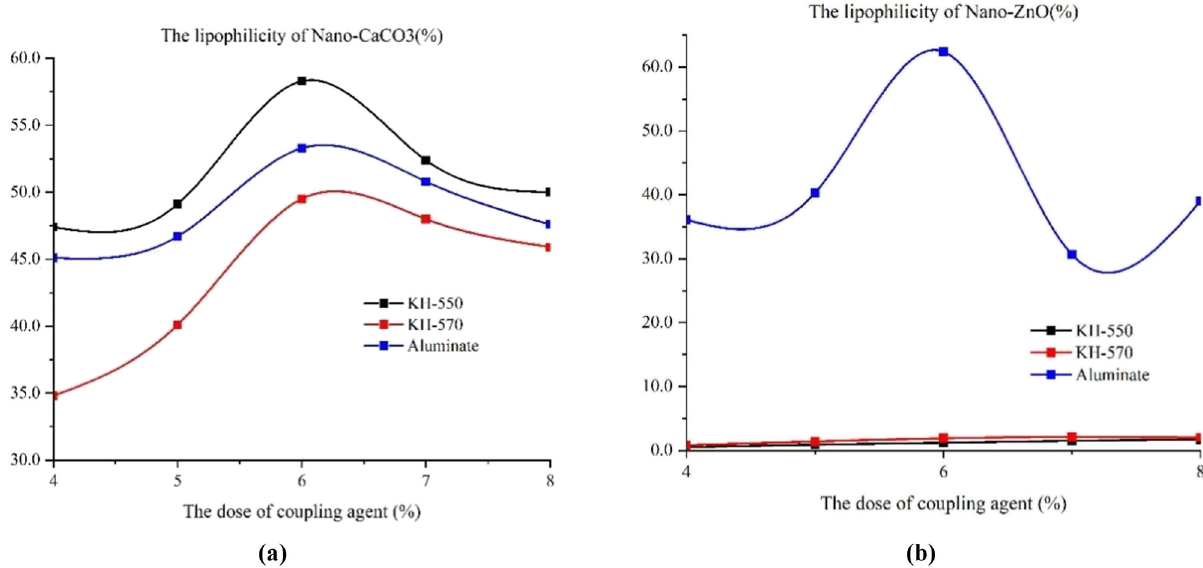
Figure 1: Lipophilic degree of activated nanomaterials: ( a ) lipophilic degree of activated nano - CaCO 3 and ( b ) lipophilic degree of activated nano -